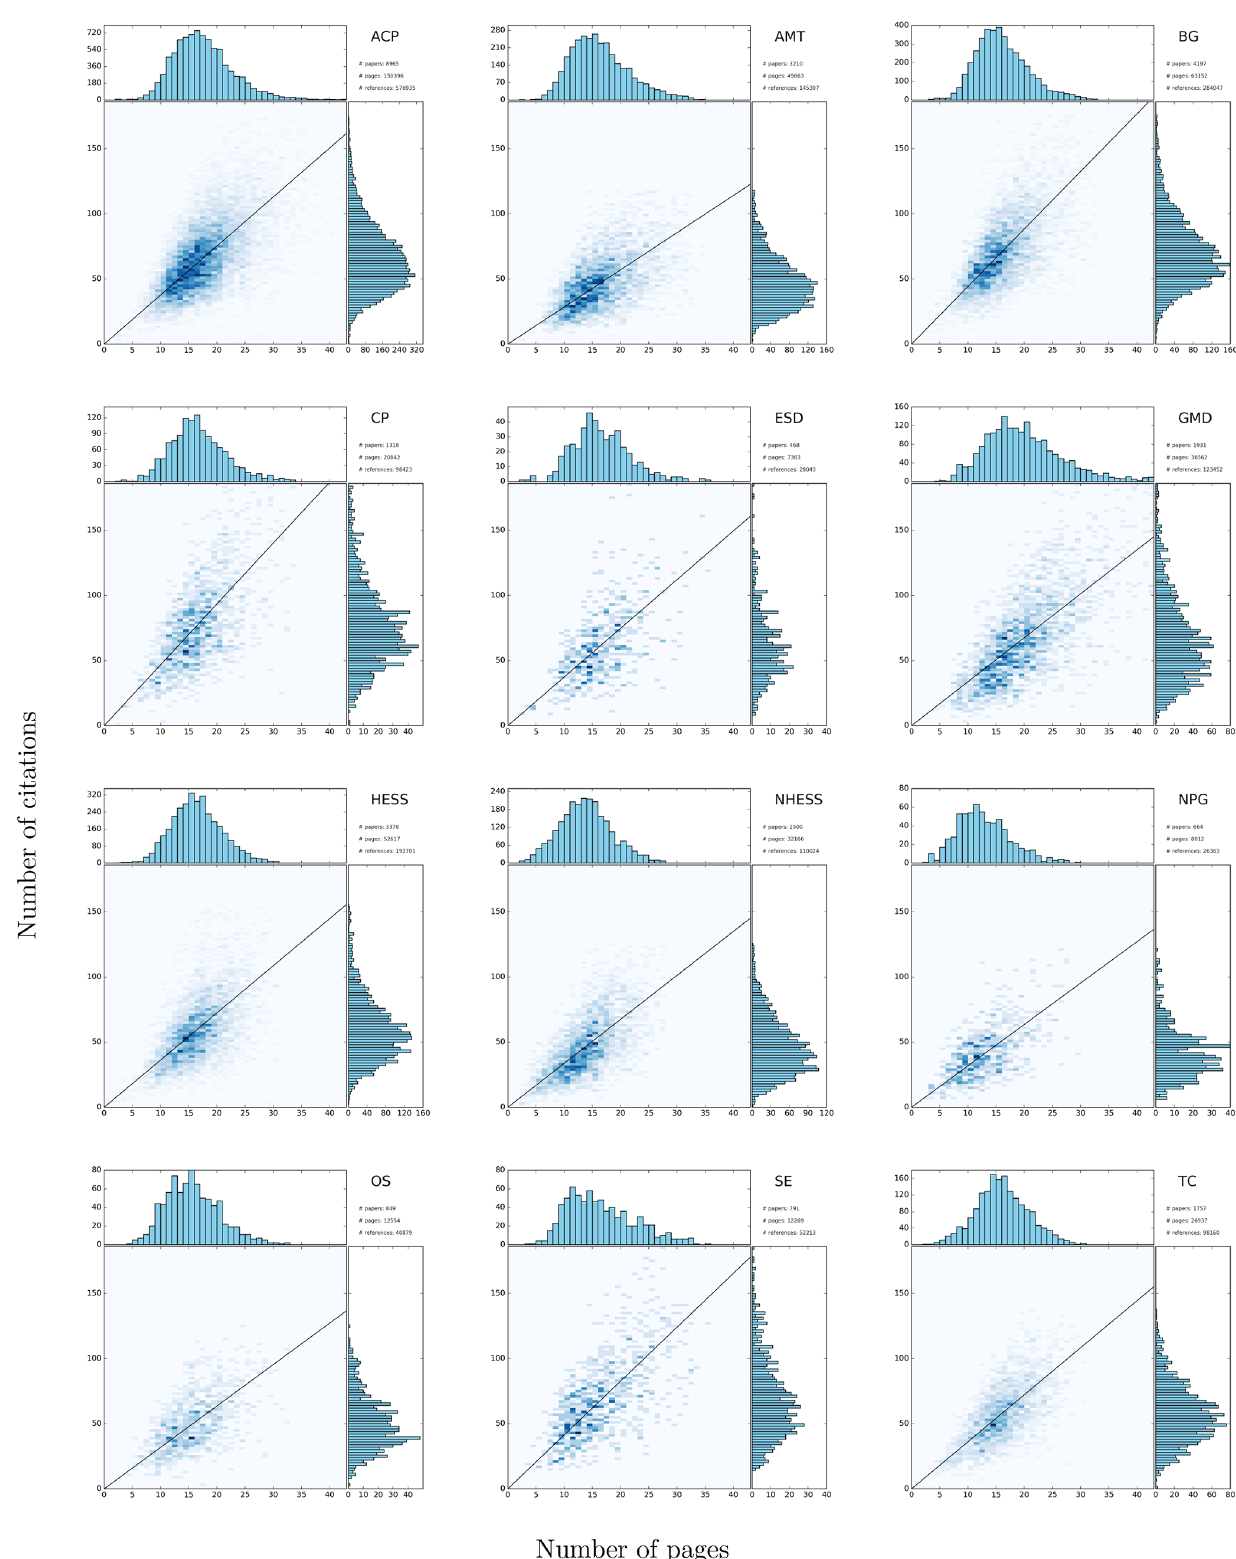
Figure 1. Shown are two-dimensional histograms (centre) with frequency histograms for pages (top) and references (right) for different EGU journals. The journal abbreviation and the total number of papers, pages and references are listed on the top right of each plot. The black line depicts the linear fit (with no intercept). The axes for the two-dimensional histograms are the same in all plots. Geosci. Commun., 4, 453–460, 2021